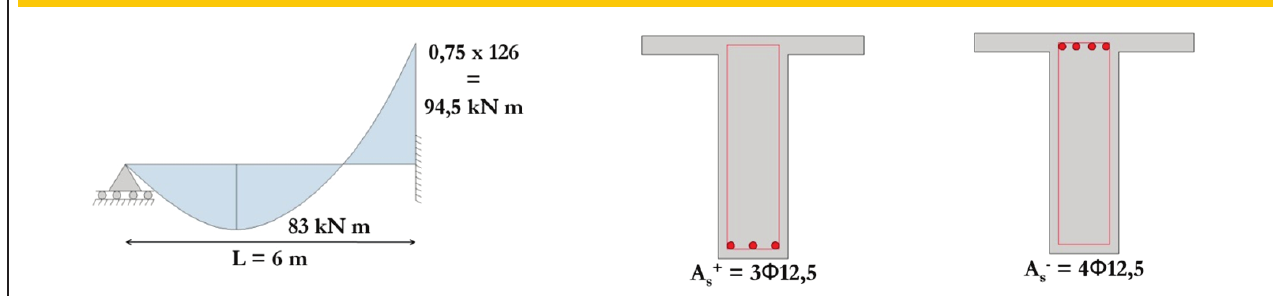
Figure 12 – Diagram of design bending moments and reinforcement bars at room temperature after the redistribution of moments